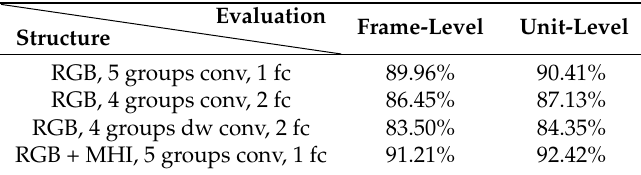
Table 4. Coarse wall classifier: Performance of RGB and RGB + MHI structures. conv: convolutional layer. dw conv: depthwise separable convolution. fc: fully connected layer.